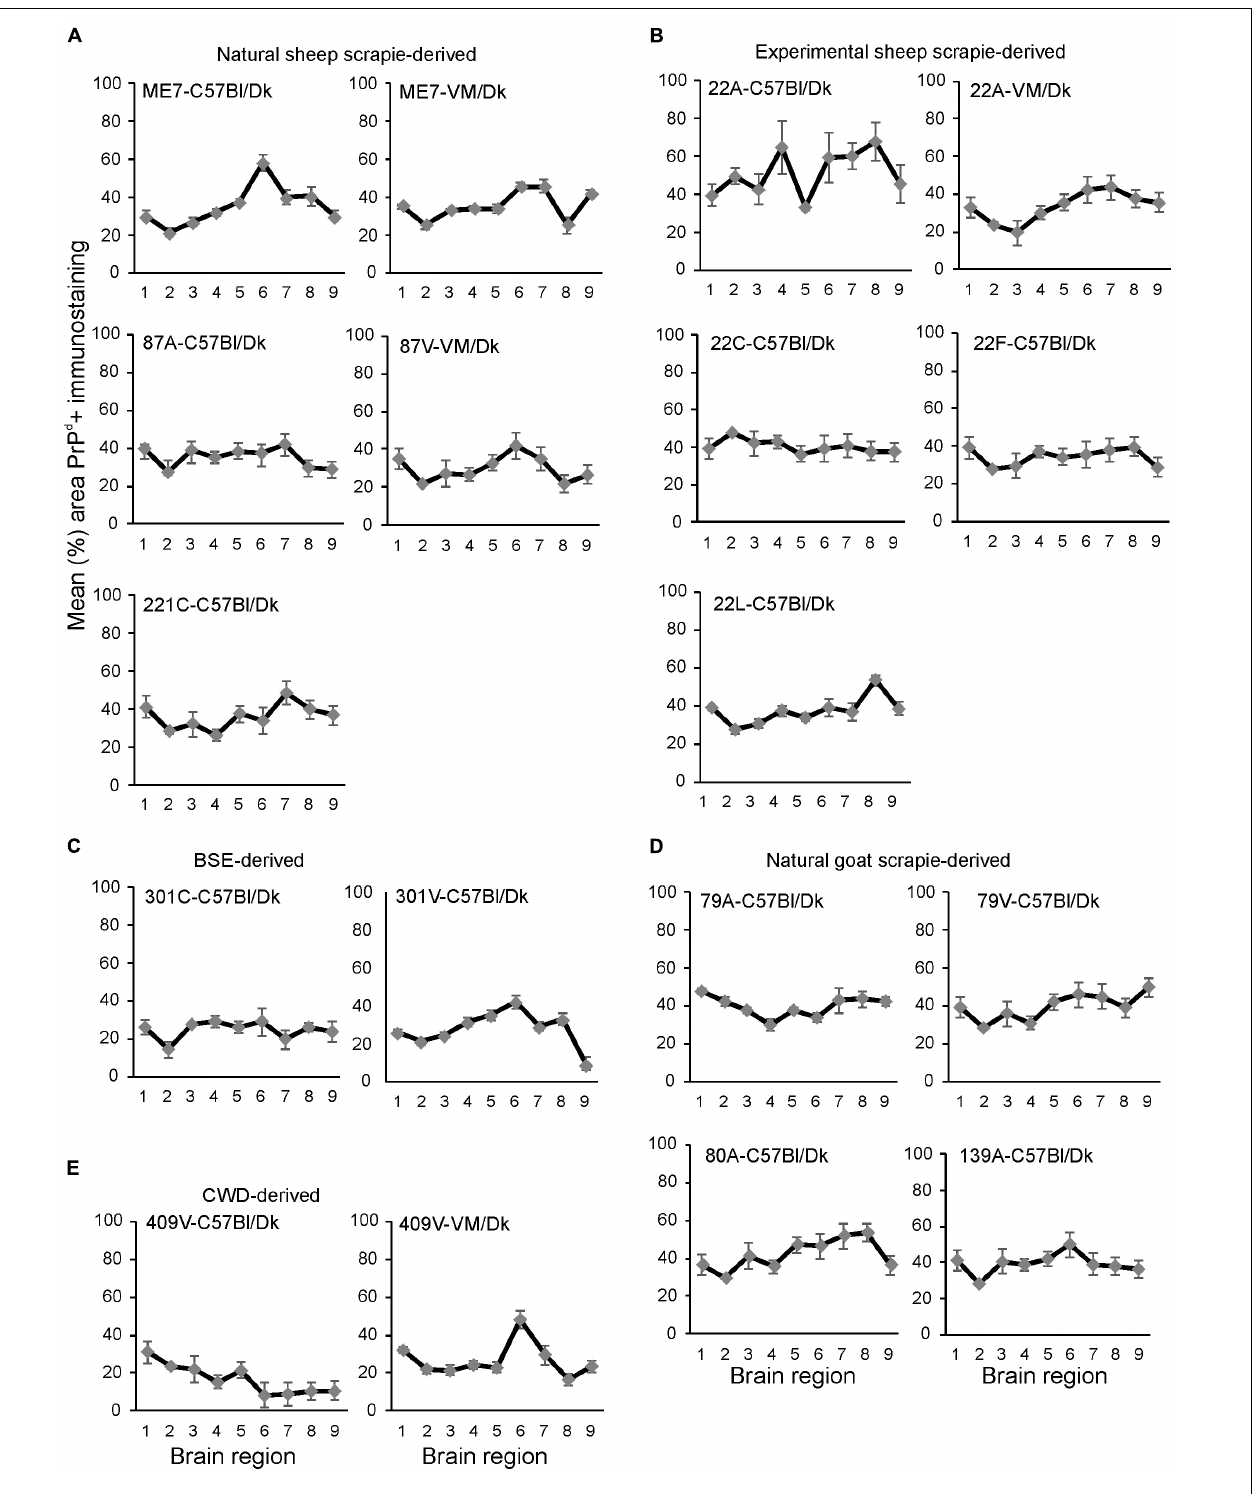
FIGURE 4 | (A–E) Comparison of the magnitude and distribution of the PrPd + immunostaining in the brains of mice infected with a variety of distinct prion agent strains. Groups of C57Bl/Dk or VM/Dk mice were injected intracerebrally with a variety of distinct prion agent strains ( Table 1 ). Brains were collected at the terminal stage of disease and immunostained to detect PrP d and the percentage area coverage compared in each of the following gray matter brain regions G1, dorsal medulla; G2, cerebellar cortex; G3, superior colliculus; G4, hypothalamus; G5, medial thalamus; G6, hippocampus; G7, septum; G8, cerebral cortex; G9, forebrain cerebral cortex. N = 6 mice/group. Data represent mean ± SEM, from a minimum of 54 images/group.